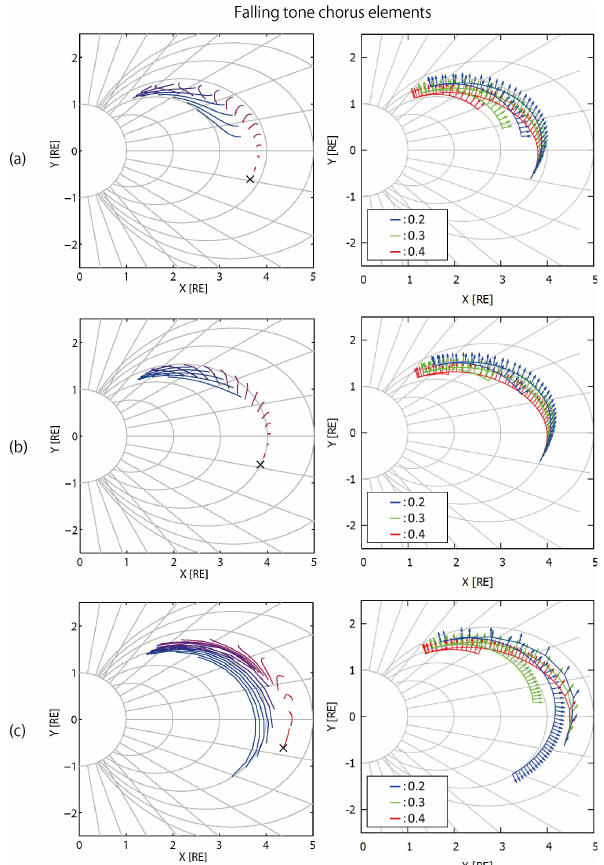
Fig. 4. Ray tracing for falling tone chorus elements with fre- quency span f = 0 . 4–0.2 (cid:127) e / 2 π (Hz), pulse length 50ms for (a) L = 3 . 8, (b) L = 4 . 0, and (c) L = 4 . 5. In accordance with Nunn and Omura (2012) starting points are 4000km upstream from the equa- tor. Left-hand panels show pulse evolution with time, the right-hand panels k vector evolution for three selected frequencies, f = 0 . 2, 0.3, 0.4 (cid:127) e / 2 π